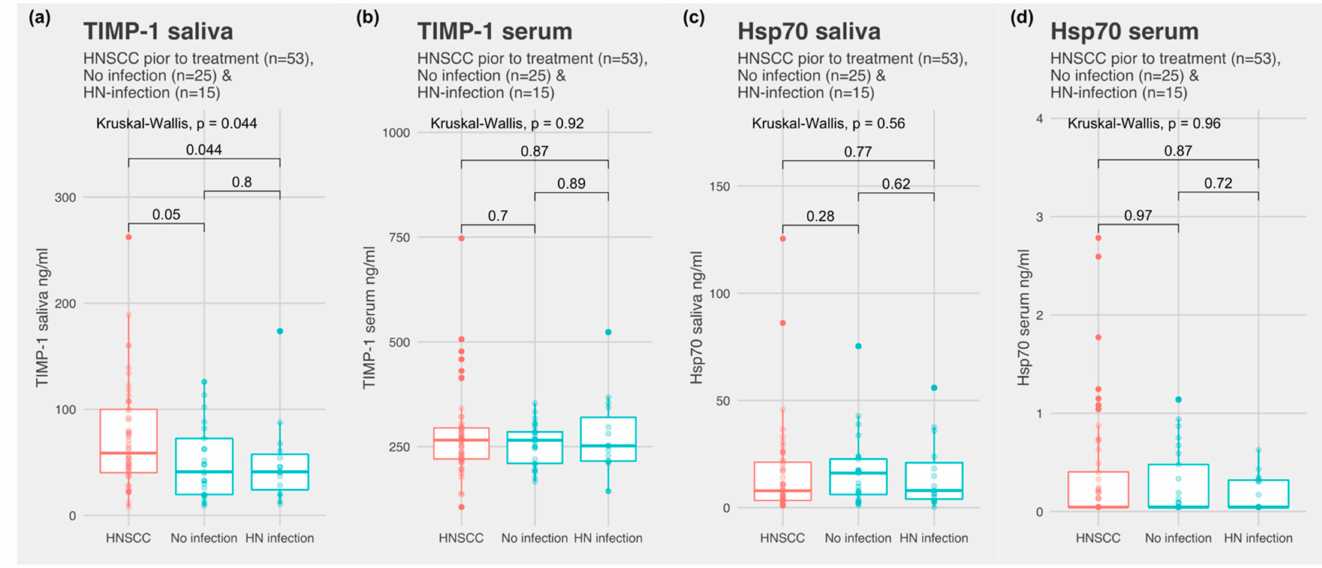
Figure 2. ( a ) TIMP-1 saliva concentration in subjects with HNSCC, control subjects without infection, and control subjects with head and neck infection; ( b ) TIMP-1 serum concentration in subjects with HNSCC, control subjects without infection, and control subjects with head and neck infection; ( c ) Hsp70 saliva concentration in subjects with HNSCC, control subjects without infection, and control subjects with head and neck infection; and ( d ) Hsp70 serum concentration in subjects with HNSCC, control subjects without infection, and control subjects with head and neck